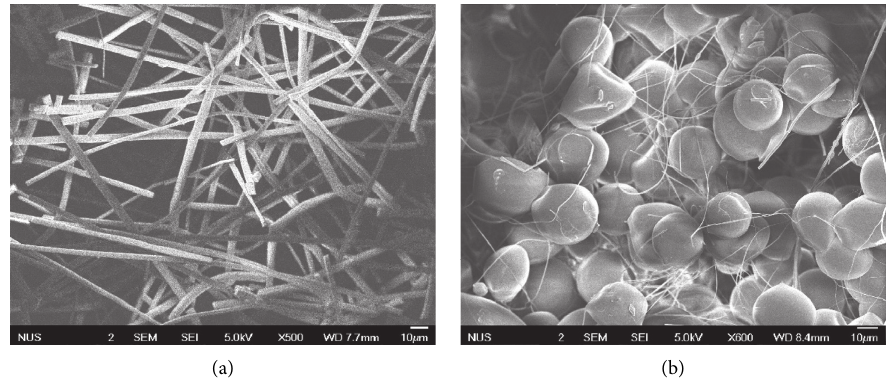
Figure 1: Scanning electron micrographs of PS nanofibers: (a) short and discontinuous and (b) beaded structures.